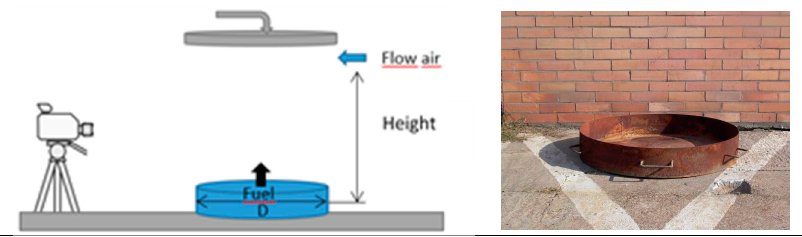
Figure 2. The experimental setup of pool fire and real picture.